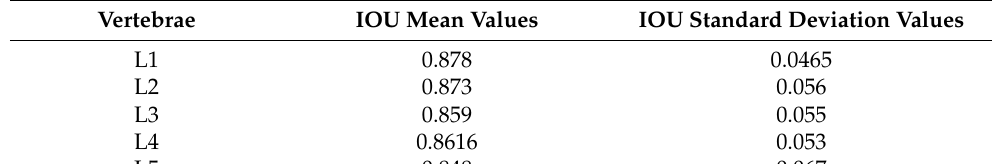
Table 2. This table represents the mean and standard deviation of IOU. L1 has the highest value of IOU mean with lowest value of std.